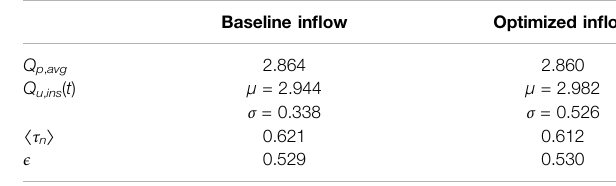
TABLE 3 | Summary of ventilation measures for the in fl ow sensitivity